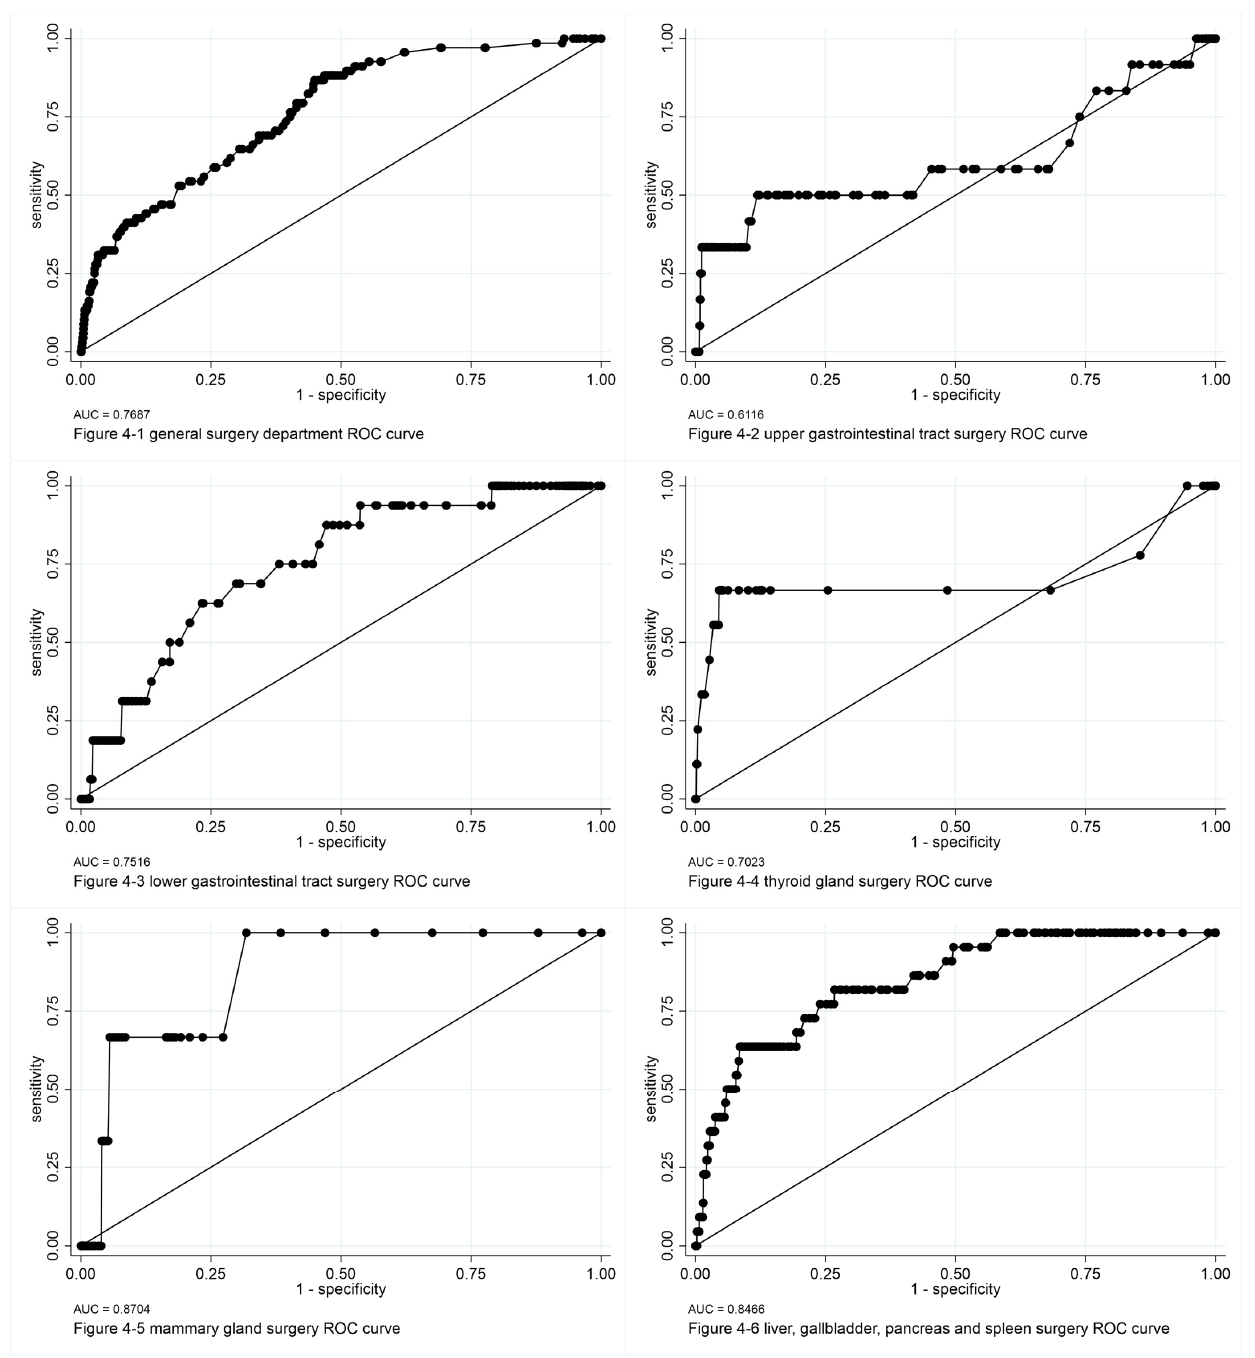
Figure 4. ROC curves of logit models of perioperative prophylactic antibiotic rational use analysis. ROC: receiving operator characteristic, AUC: area under the ROC curve.